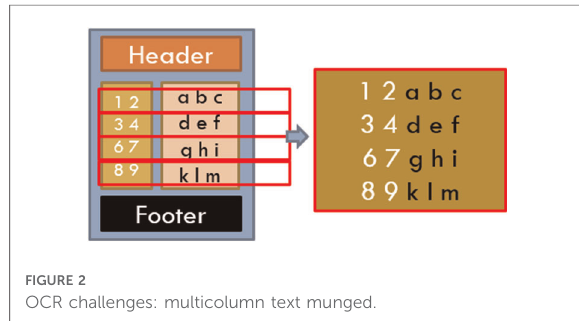
FIGURE 2 OCR challenges: multicolumn text munged.